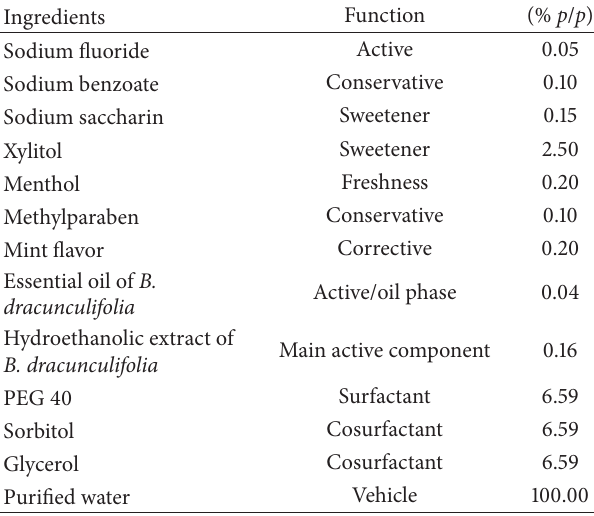
Table 2: Composition of C formulation—mouthwash with B. dracunculifolia .